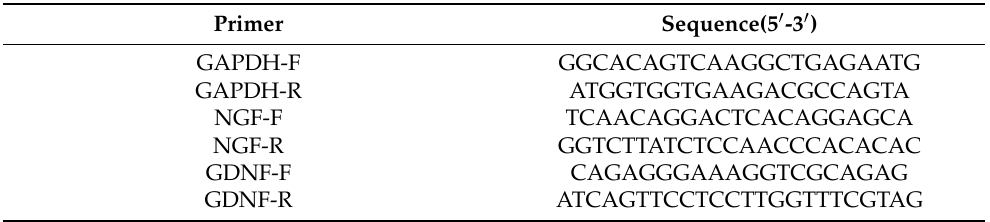
Table 1. The primers for genes used in quantitative real-time RT-PCR.